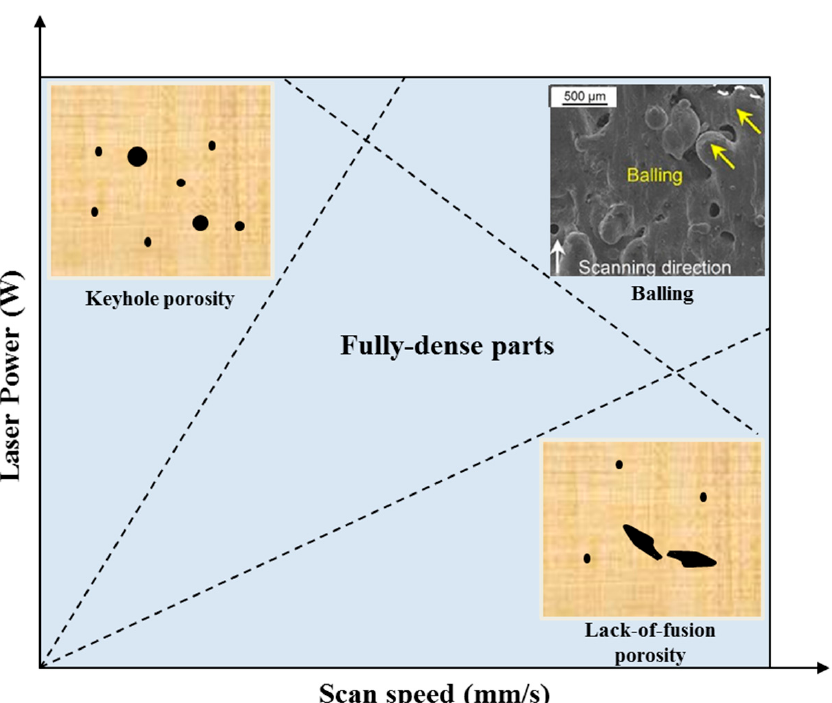
Figure 8. Influences of laser power and scanning velocity on porosity. Reproduced with permission from Elsevier [70,114].